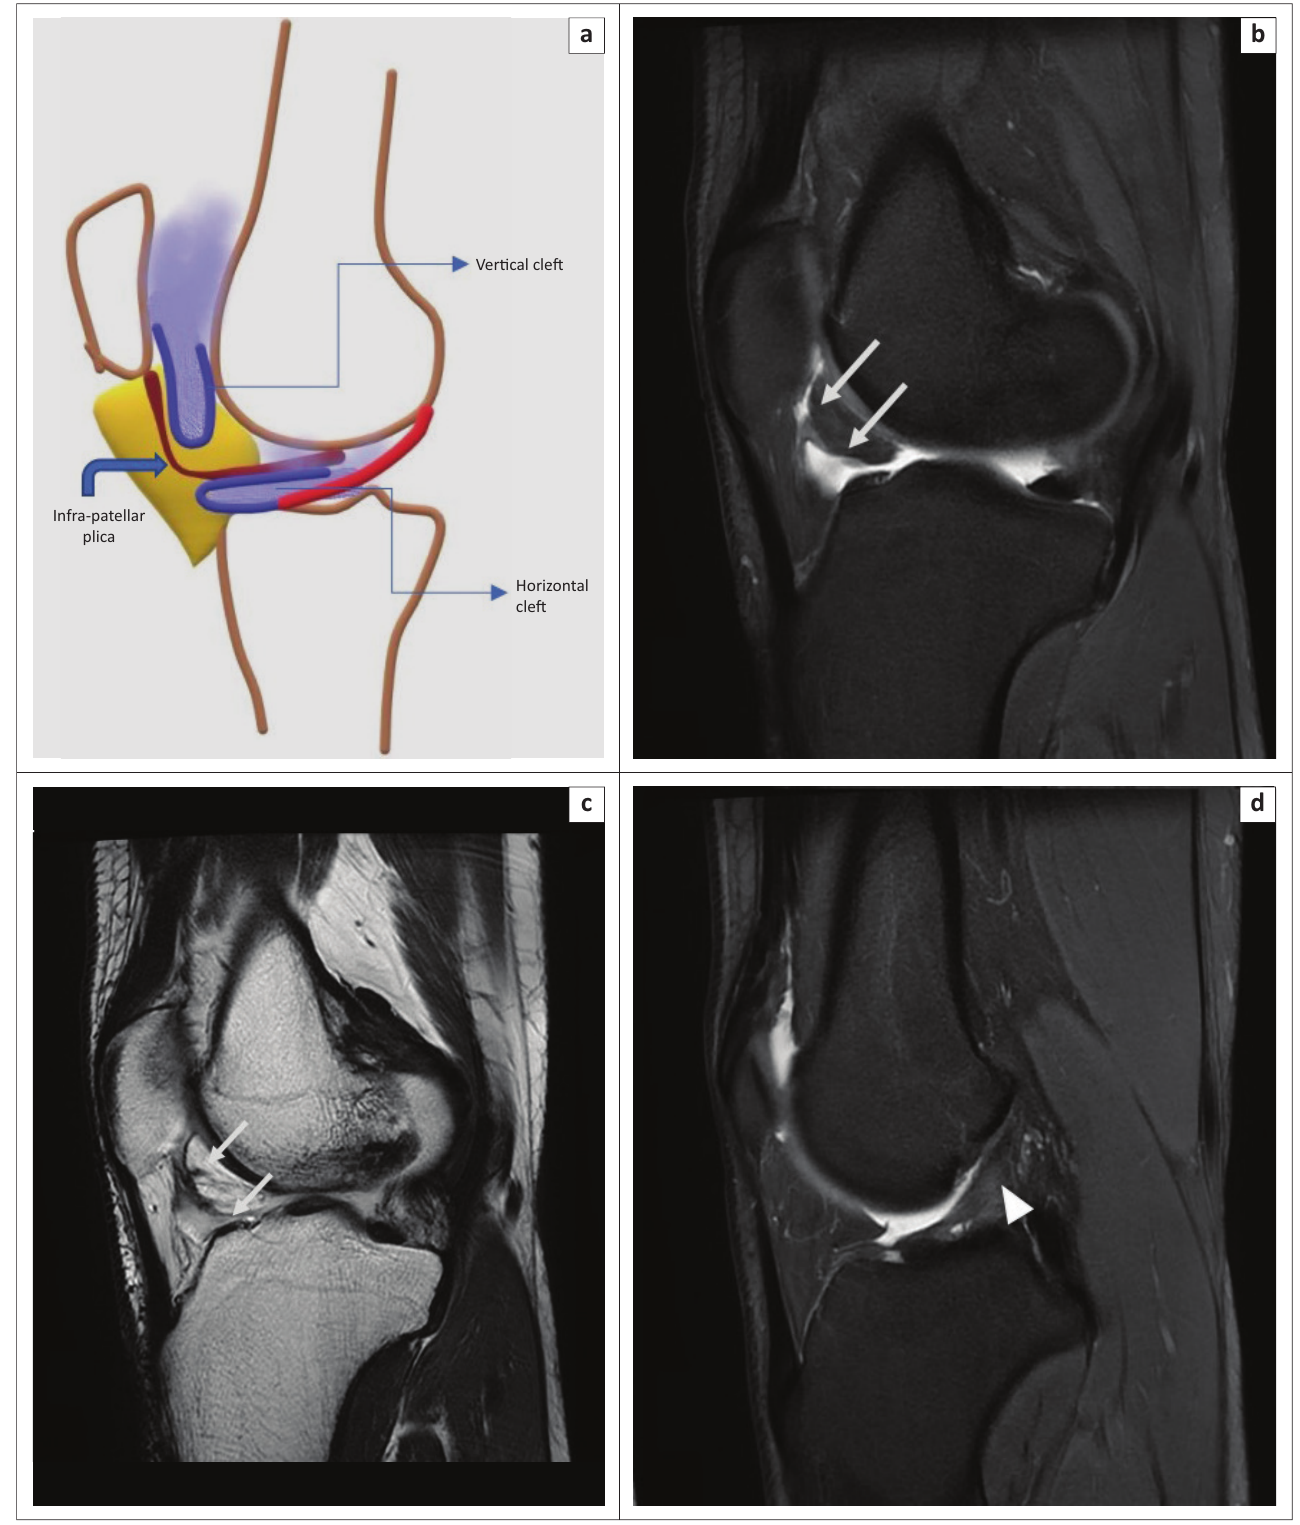
FIG URE 10: Magnetic resonance imaging of normal synovial clefts in Hoffa’s fat pad: schematic diagram (a) of the vertical (supra-Hoffotic) cleft and horizontal (infra-Hoffotic) cleft in relation to the infrapatellar plica. Magnetic resonance imaging, images (b–d) of normal supra-Hoffotic and infra-Hoffotic recesses in a 29-year-old boy with a history of a fall and clinically-suspected anterior cruciate ligament (ACL) injury. Oblique sagittal PDFS image (b) and oblique sagittal T2WI image (c) indicate hyperintense fluid-filled synovial clefts, contiguous with the joint fluid. Note the mild sprain in middle third of the ACL in (d), sagital PDFS